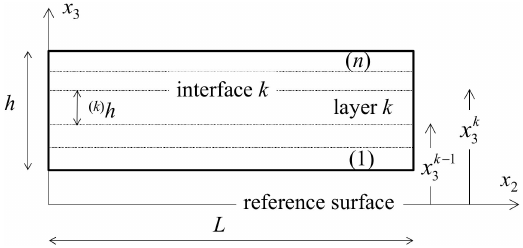
Figure 1. Layered beam